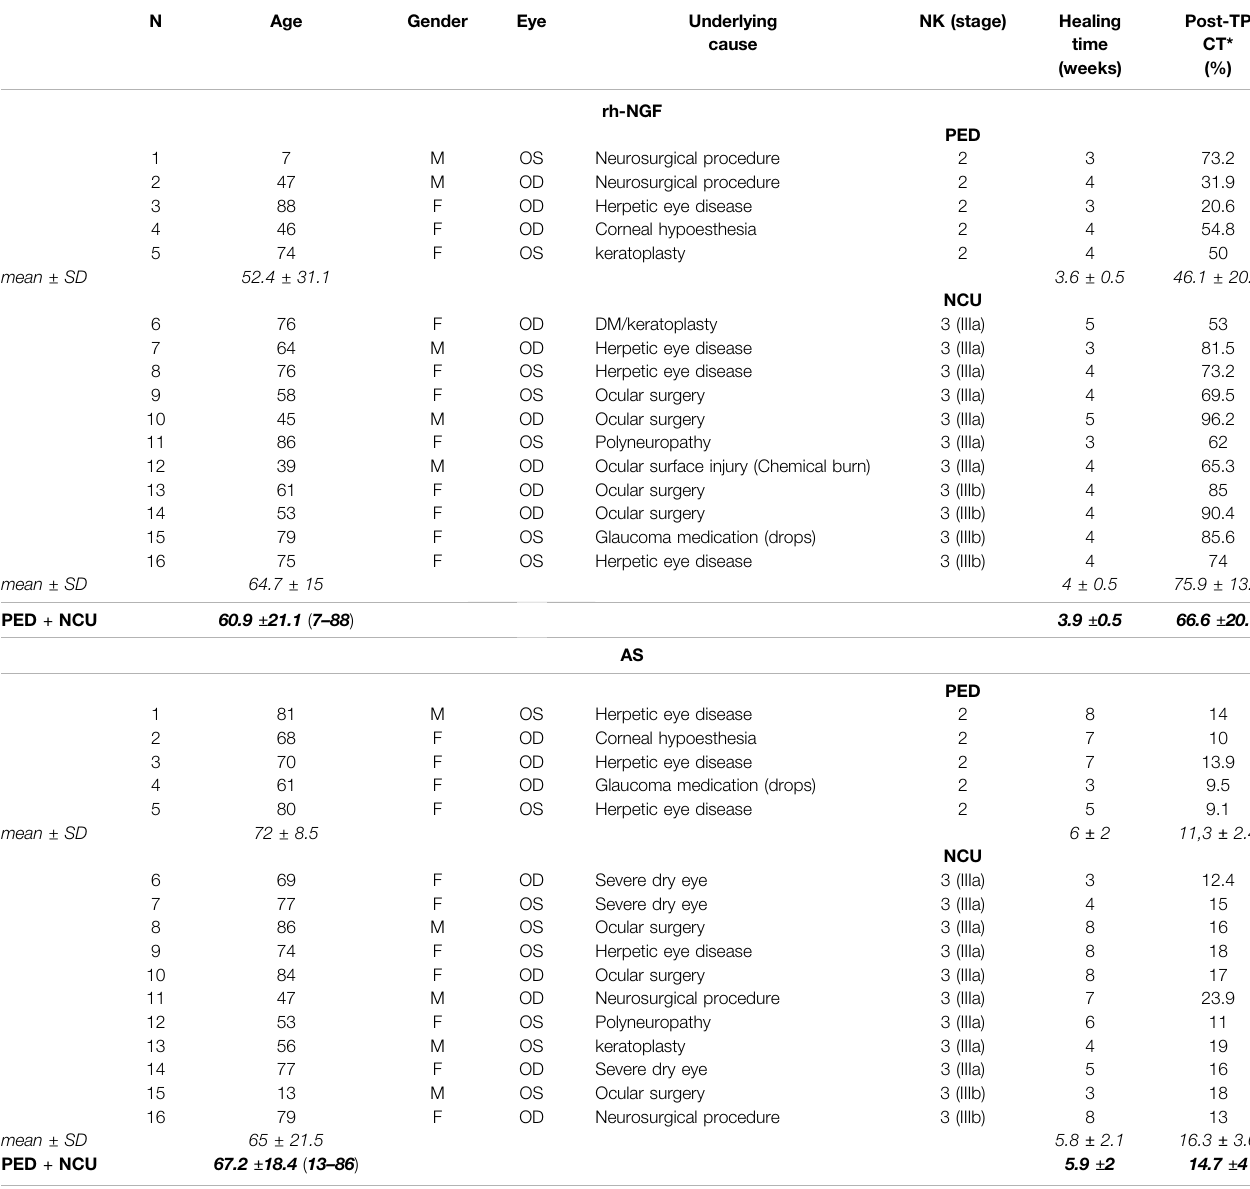
TABLE 1 | Ocular and demographic characteristics of the treated cases and the control group, *measured by AS-OCT. N Age Gender